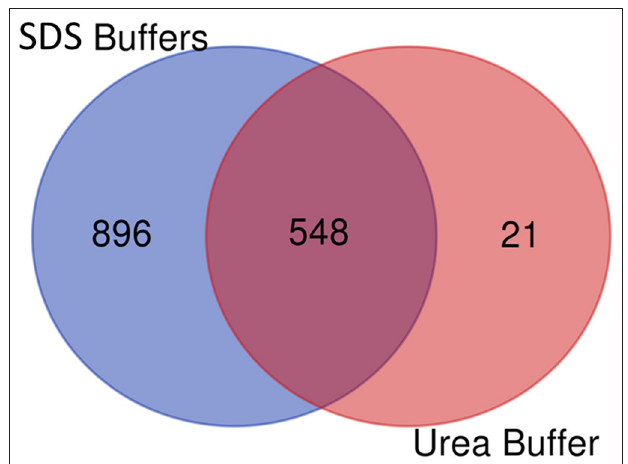
FIGURE 7 | Venn diagram showing the number of common and unique proteins identified after using SDS-containing buffers [ buffer 1 (Tris-SDS LB), buffer 3 (Tris-SDS-DTT-Glycerol LB), buffer 4 (citrate-SDS LB), buffer 5 (SDS-LB), and buffer 6 (RIPA LB)] and the urea-containing buffer [ buffer 2 (urea